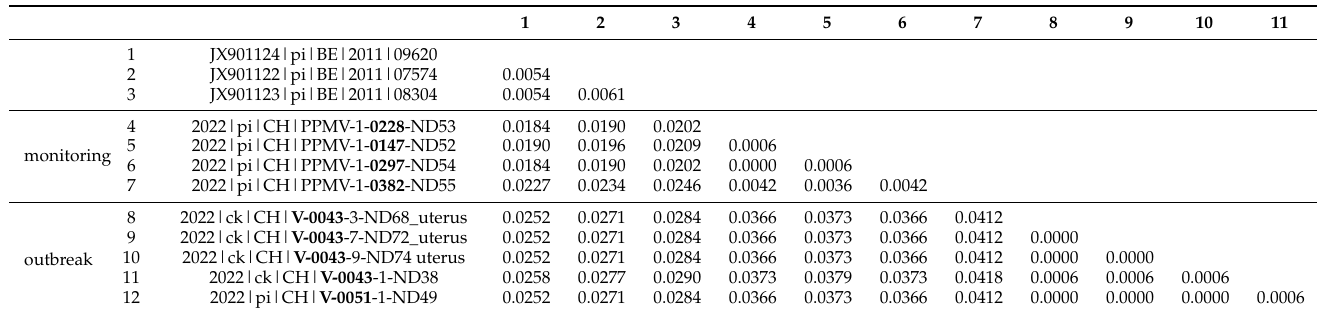
Table 2. Estimates of Evolutionary Divergence between Swiss PPMV-1 viruses 1